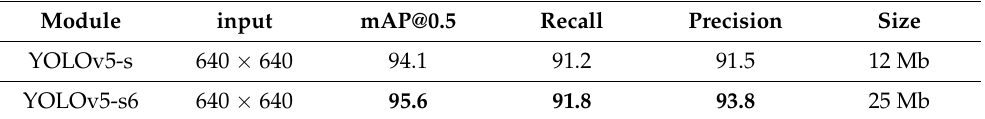
Table 2. YOLOv5 Performance on validation dataset.